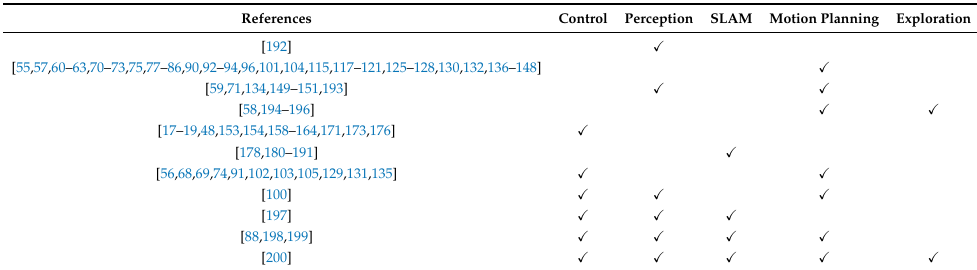
Table 2. A summary of some recent developments for UAVs in control, perception, SLAM and motion